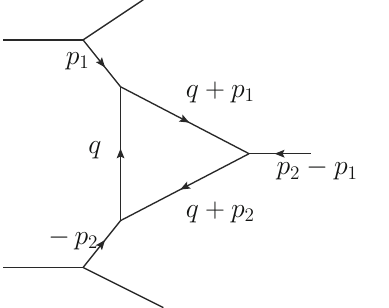
Fig. 11 Triangle t -channel (sub)topology that gives rise to Δ 12 → 0 numerical instabilities when ( p 2 − p 1 ) 2 = 0 and p 2